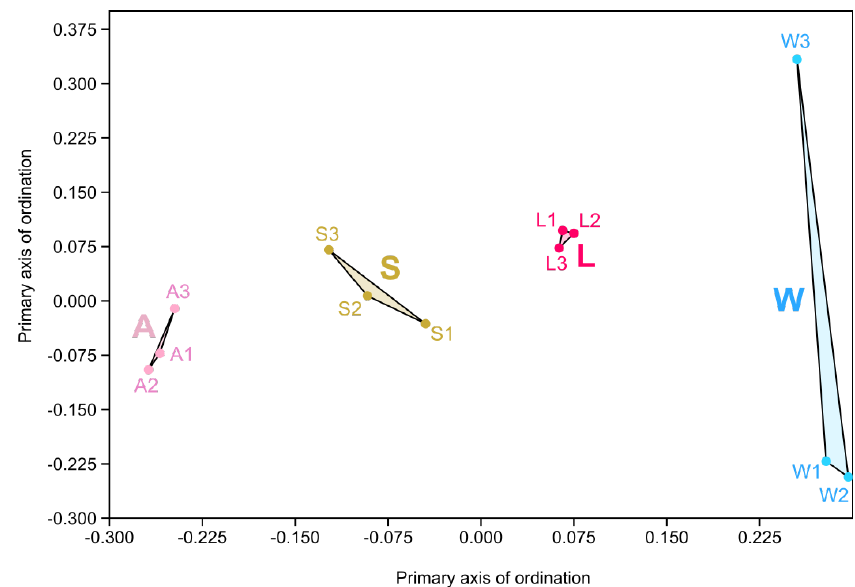
Figure 4. Non-metrical multidimensional scaling (NMDS) plot of the Bray–Curtis dissimilarity matrix of the OTU distribution in P. cyanorosea adults (pink), larvae (red), ambient seawater (blue) and sediment (ochre). Ordination stress was 0.12 in the scale of 0–1.0. Abbreviations: A: adults; L: larvae; W: seawater; S: sediment.